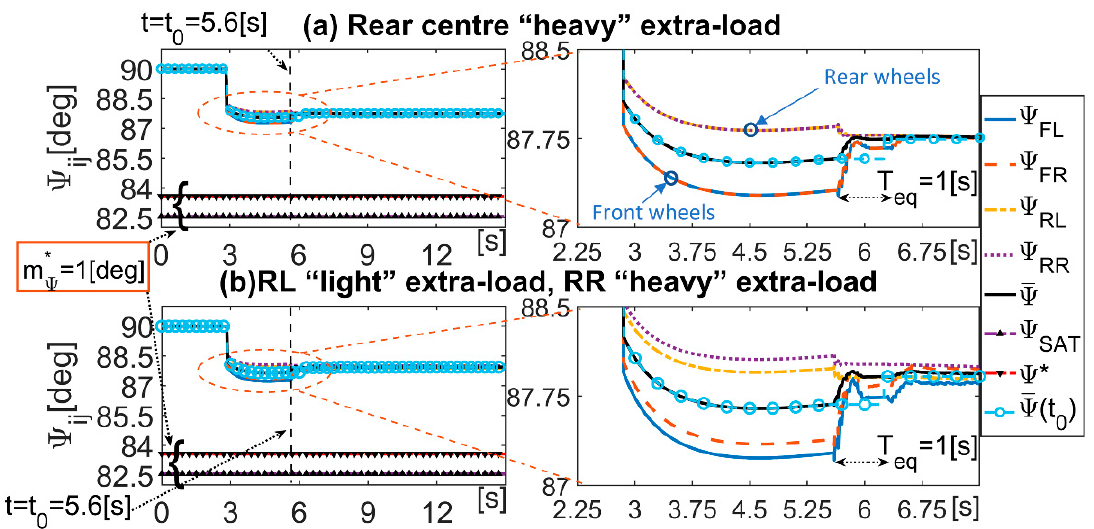
Figure 17. SV Equalization: four wheel angles Ψ ij equalization.